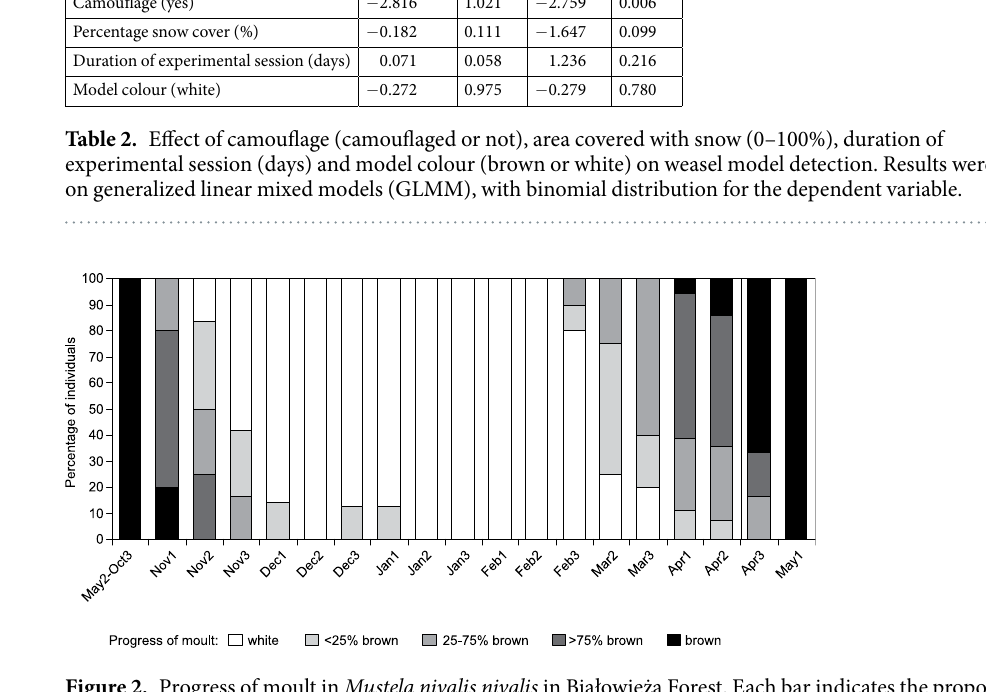
Figure 2. Progress of moult in Mustela nivalis nivalis in Białowieża Forest. Each bar indicates the proportion of individuals at different stages of moult, summarized for the years 2002–2017 (N = 130 observations of moulting animals). Each month was divided into 10-day periods. From the beginning of May until the end of October only brown individuals were present in the population. Percentage of brown colour refers only to the dorsal part of the weasel body (see Fig. S2 for